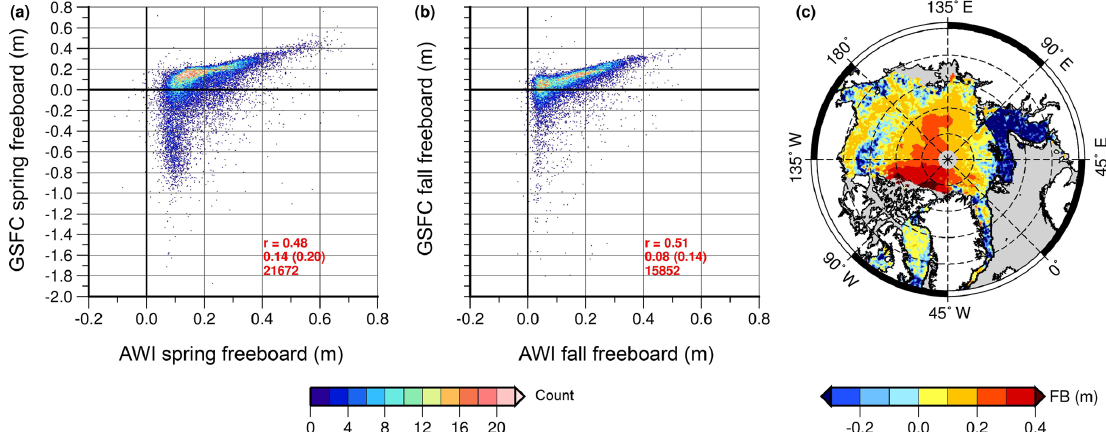
Figure 10. Comparison of sea ice freeboard in the GSFC and AWI data products for (a) March–April and (b) October–November, for the period 2011–2018, regions 1–14, north of 65 ◦ N. Colour indicates measurement density, derived from the number of data points within each 0.01m cell. Statistics for correlation ( r ), mean difference (SD) and number of data points are provided. (c) GSFC product freeboard for April